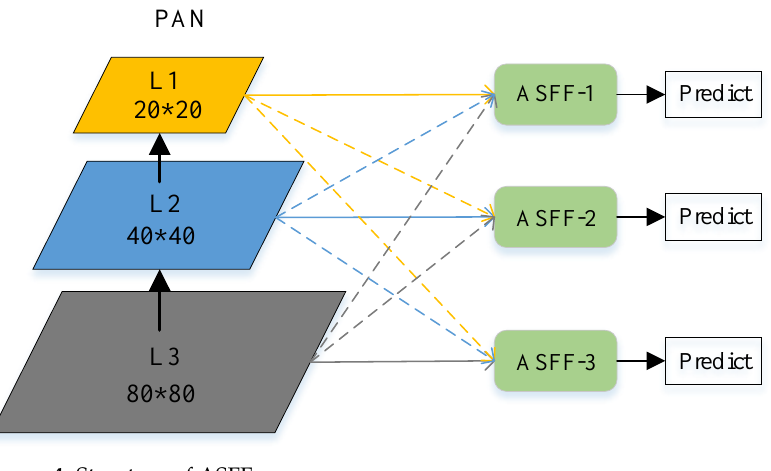
Figure 4. Structure of